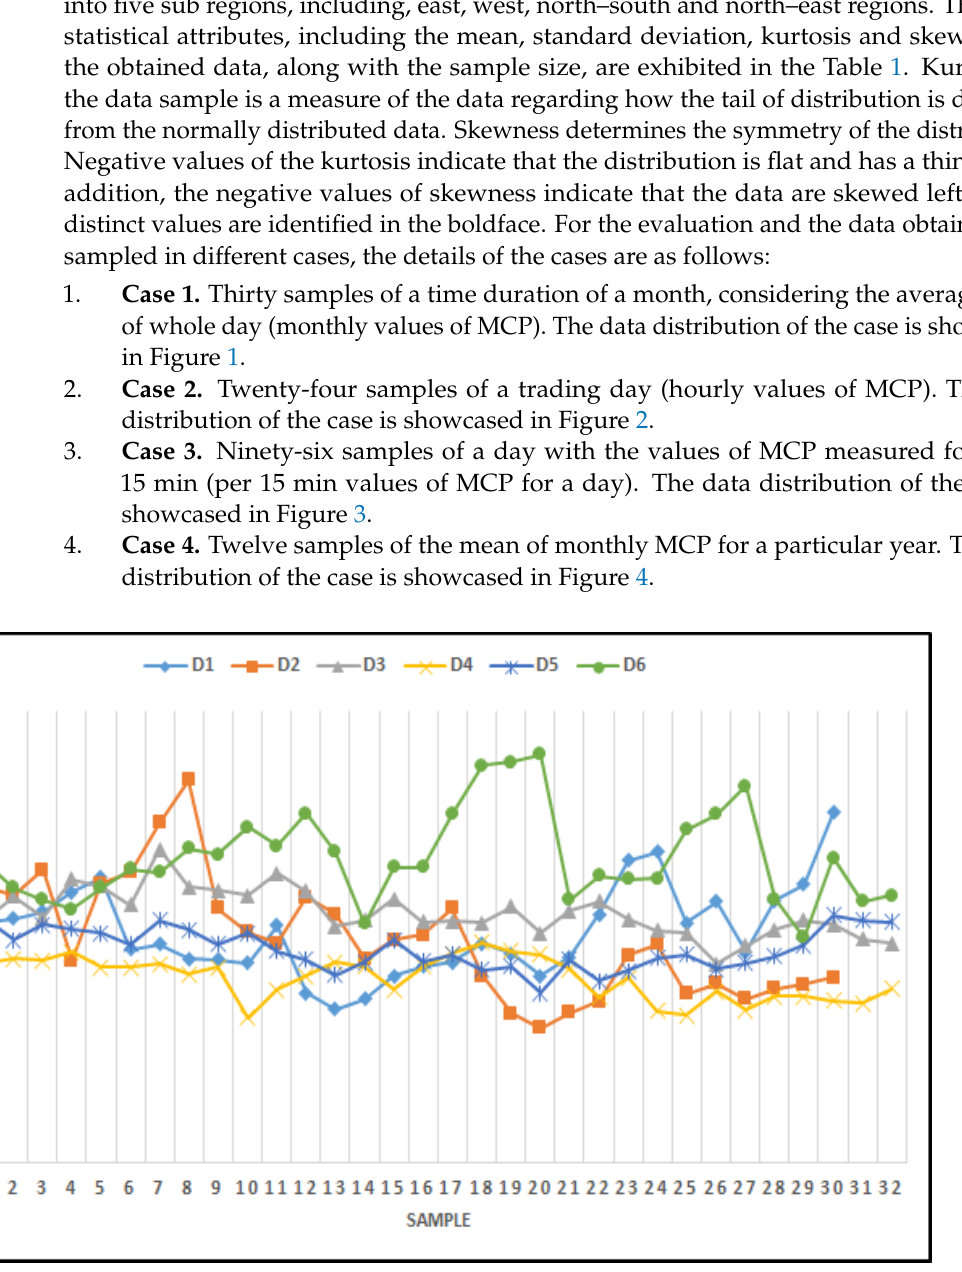
Figure 1. Data samples for evaluation of the performance of proposed cubic grey model